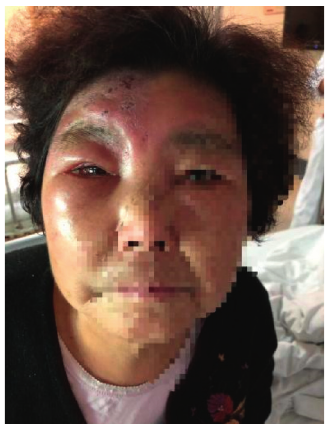
Figure 1: State of the right upper eyelid on the day of hospitali- zation (13 days after the onset of